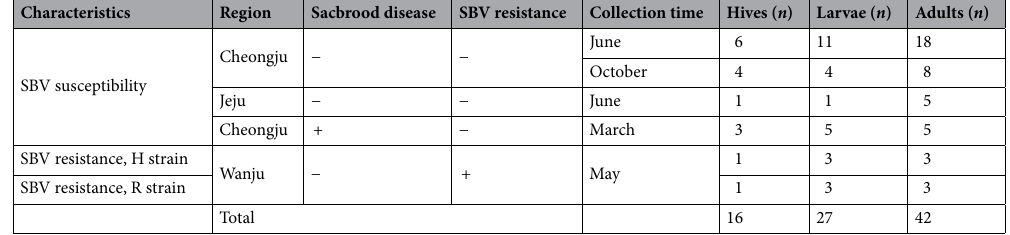
Table 1. Characteristics and sacbrood disease status of honey bee samples for gut microbiome